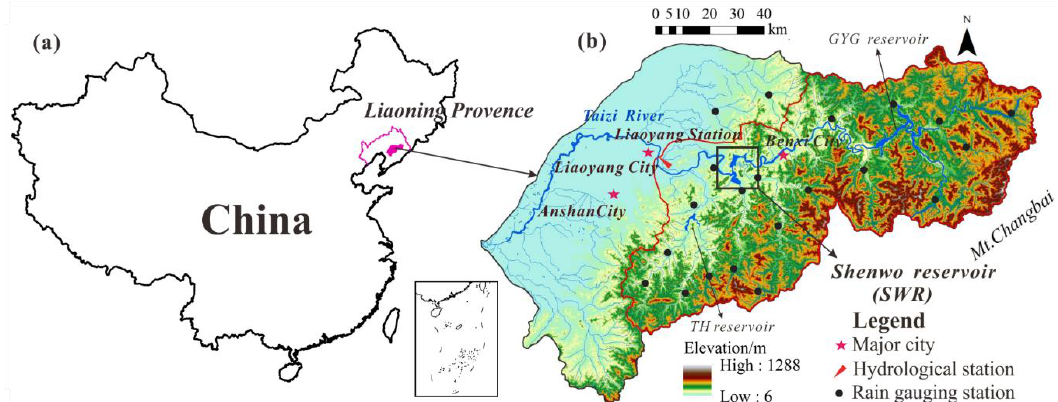
Figure 1. Location of: ( a ) the study area in China; and ( b ) hydrological station and rain gauging stations in TRB. The drainage area controlled by Liaoyang Station is surrounded by the red line, while the entire basin is surrounded by the black line.